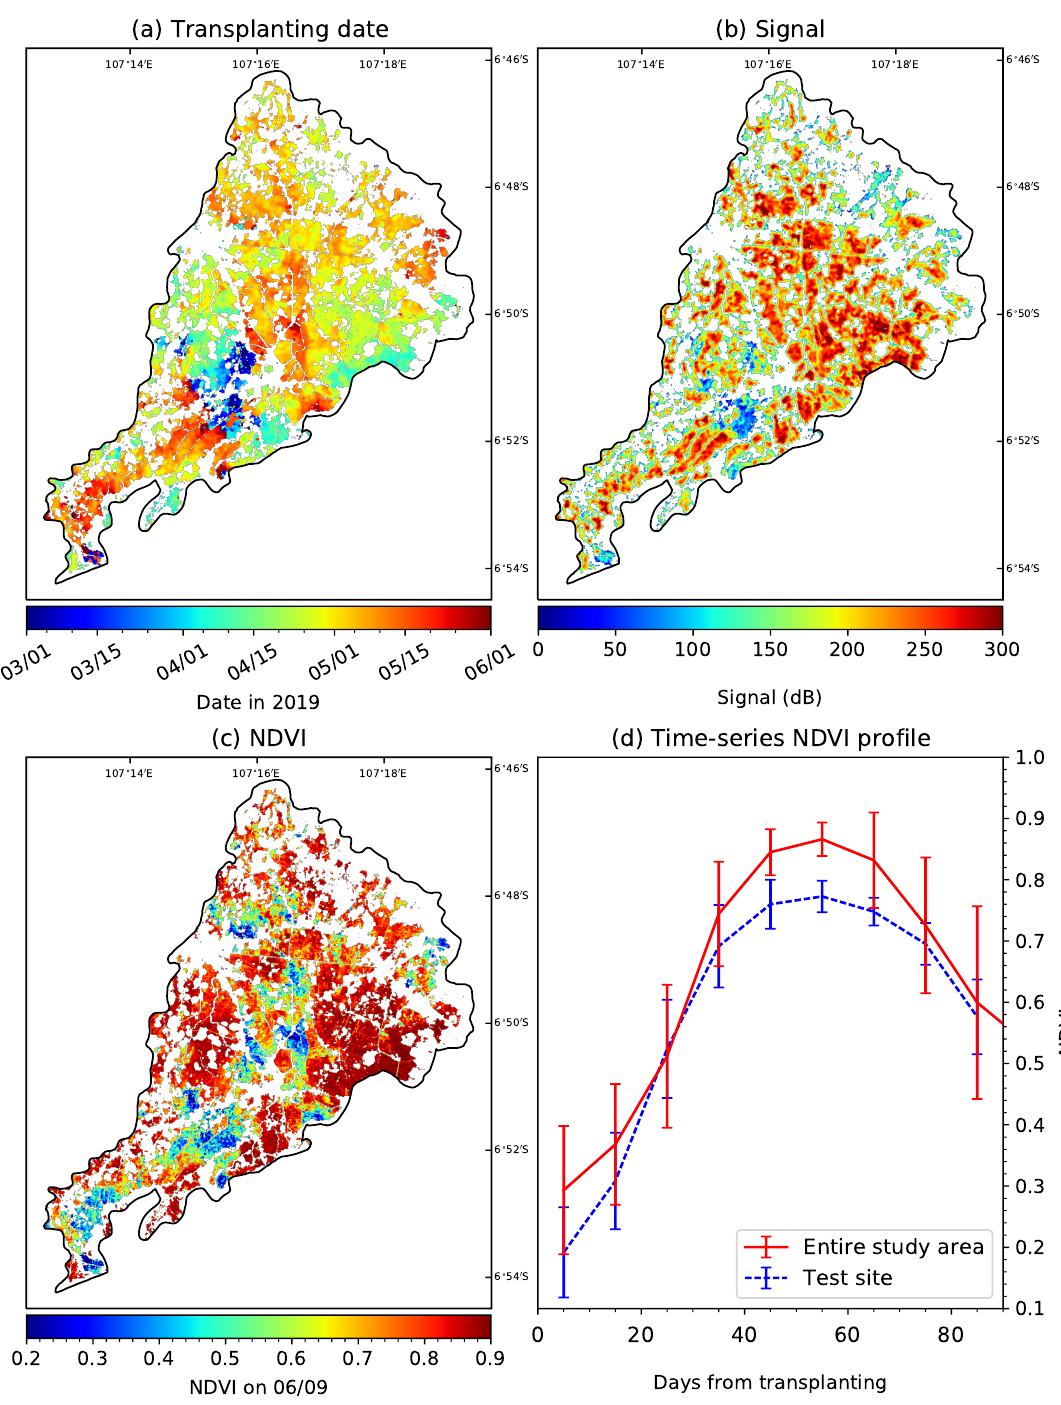
Figure 4. Comparison of estimated transplanting date and NDVI after transplantation (first crop in the dry season of 2019). Panels ( a , b ) show final estimation of the transplanting date and synthesized signal intensity obtained for each pixel in the study area, respectively. Panel ( c ) shows the NDVI calculated from the Sentinel-2 data acquired on 9 June 2019. The solid line in panel ( d ) shows the time-series profile of NDVI obtained using the estimated transplanting date in the study area and the NDVI of one scene (9 June 2019), while the dashed line shows the time-series profile of NDVI obtained using the block value of transplanting date in the test site and multi-scene NDVI acquired from April 2019 to September